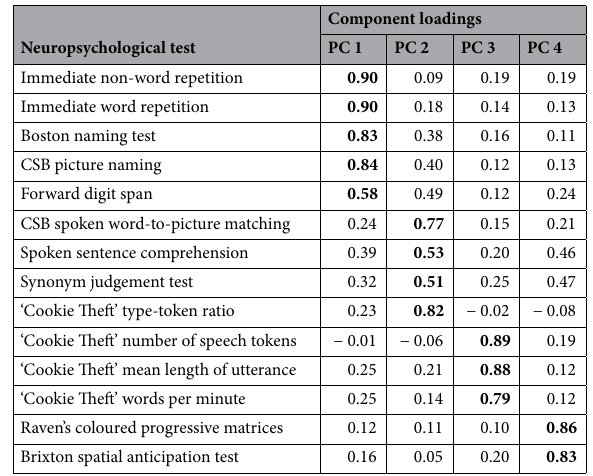
Table 2. Component matrix of neuropsychological scores from the entire cohort of participants with post- stroke aphasia. Varimax rotated principal component analysis performed on the neuropsychological scores of the entire cohort of 76 individuals with post-stroke aphasia. The loading of each score onto each rotated principal component is shown. Variables with major loadings (defined as > 0.50) are in bold. ‘CSB’ = Cambridge Semantic